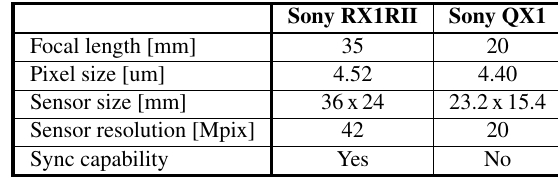
Figure 1: The Wingtra VTOL aircraft.